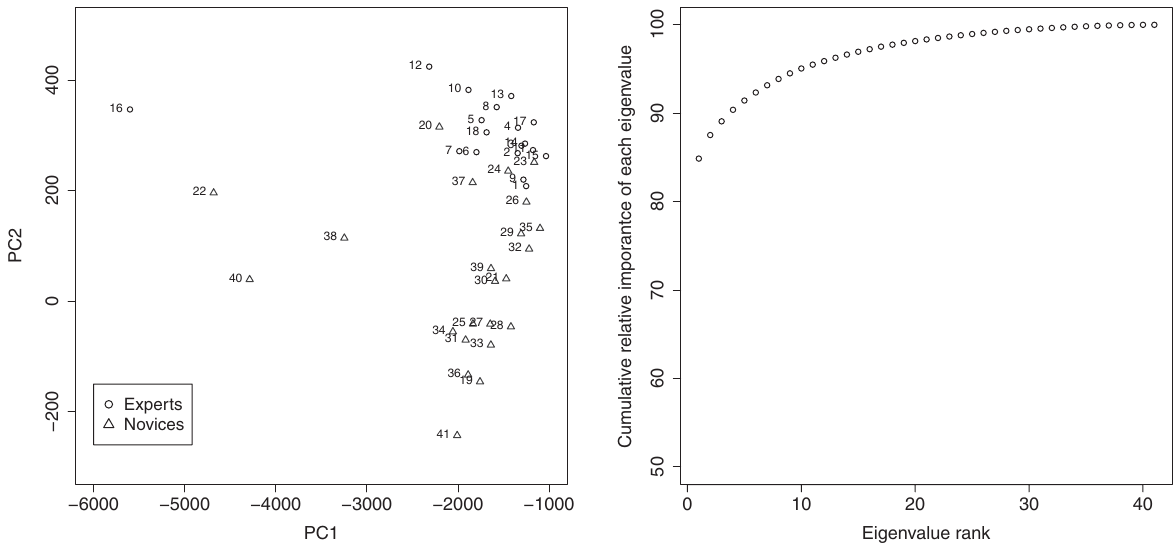
FIG. 12. PCA of the sorter data. On the left we see the PCA plot of the sorters. PC1 is the coordinate along the first principal axis, and PC2 is the coordinate along the second principal axis. Sorters known by us to be experts are marked by circles while sorters known by us to be novices are marked by triangles. Each point is labeled on the left by the sorter number. The second principal component discriminates experts from novices. On the right is a plot of the cumulative relative importance of each subsequent principal